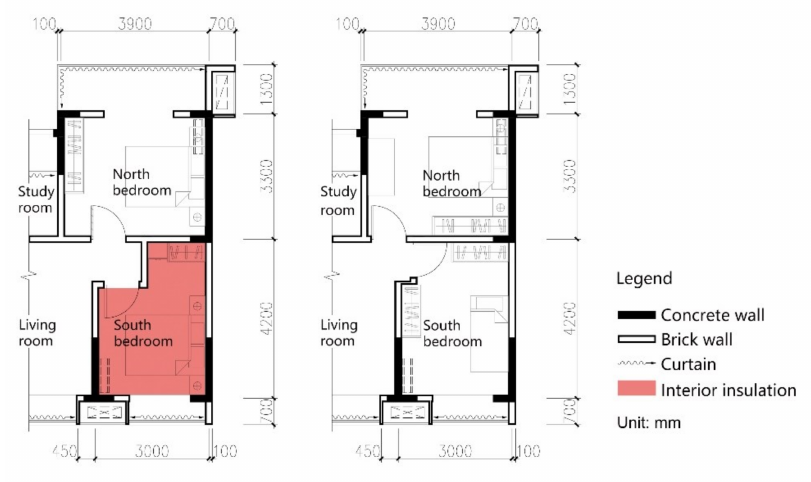
Figure 6. Layout plan of the renovation area, renovated unit (left), and original unit (right). Details of the retrofit are as follows. The insulation panels used in the building are made of extruded polystyrene (XPS) boards, of which 30 mm-thick panels are used for the walls and floors and 20 mm-thick panels for the ceiling areas. All panels are 300 mm wide, supported by a wooden keel, and then covered with a layer of gypsum plasterboard. The specific retrofit construction process is shown in Figure 7.